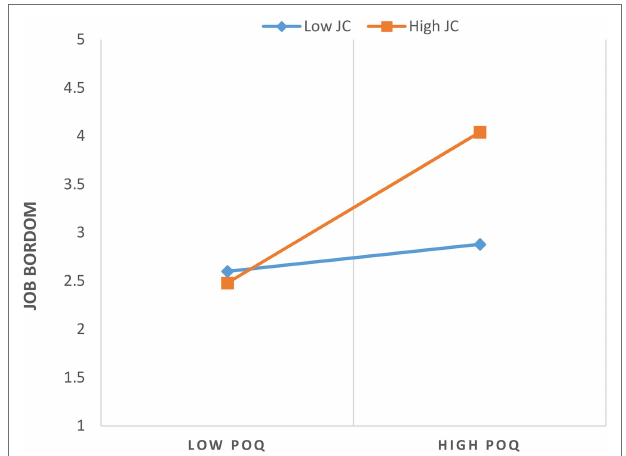
FIGURE 2 | Interactive effect of POQ and job crafting on CWB.